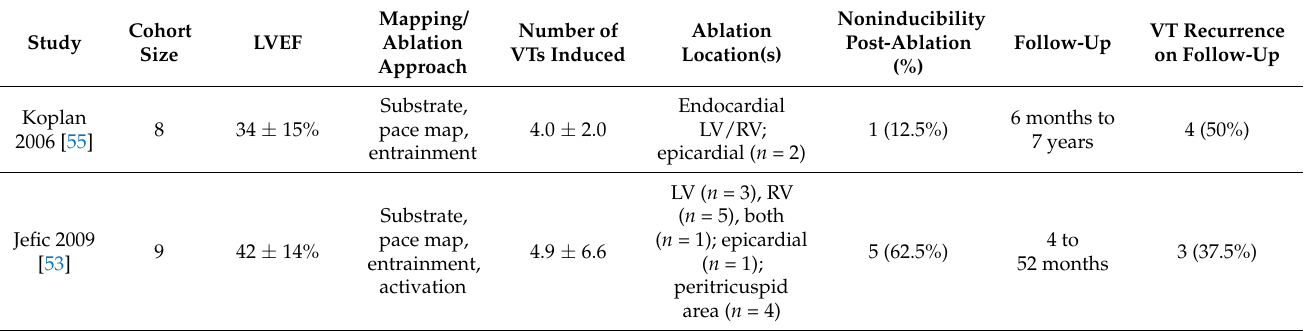
Table 1. Studies of catheter ablation for ventricular tachycardia in cardiac